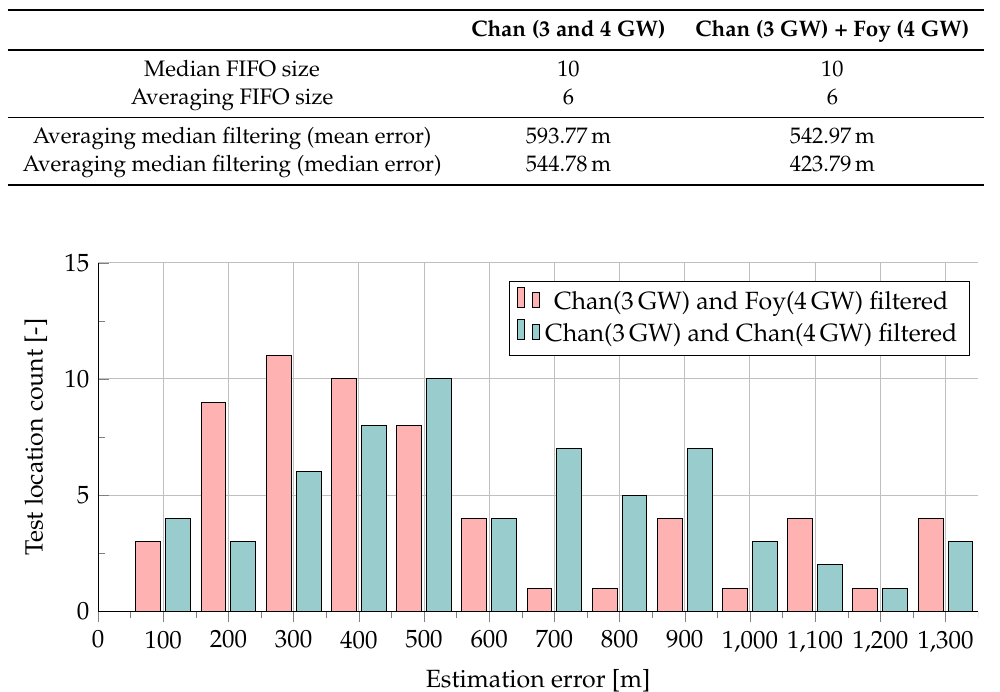
Figure 14. Filtered Chan’s and Foy’s algorithms (queues - median: 10, average: